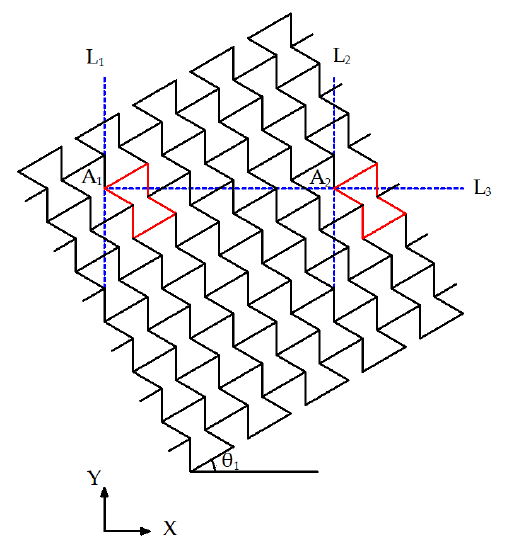
Figure A1. θ 1 re-entrant honeycomb layer.